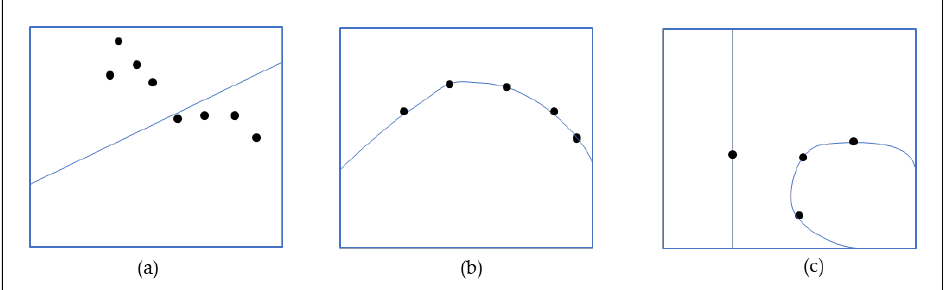
Figure 4. ( a ) Underfitting, where the model cannot capture the curve of the data. ( b ) The model fits perfectly to the curve of the data points; this curve can also train the unseen data. ( c ) The exact structure of the data cannot be captured, i.e., overfitting, where the points are covered but not in the correct